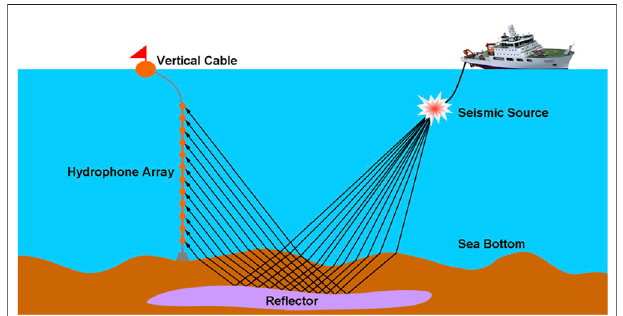
FIGURE 1 | Sketch of vertical cable seismic exploration.